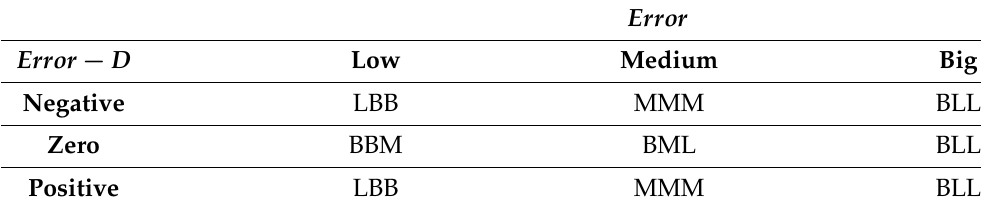
Table 1. Fuzzy Rule table.